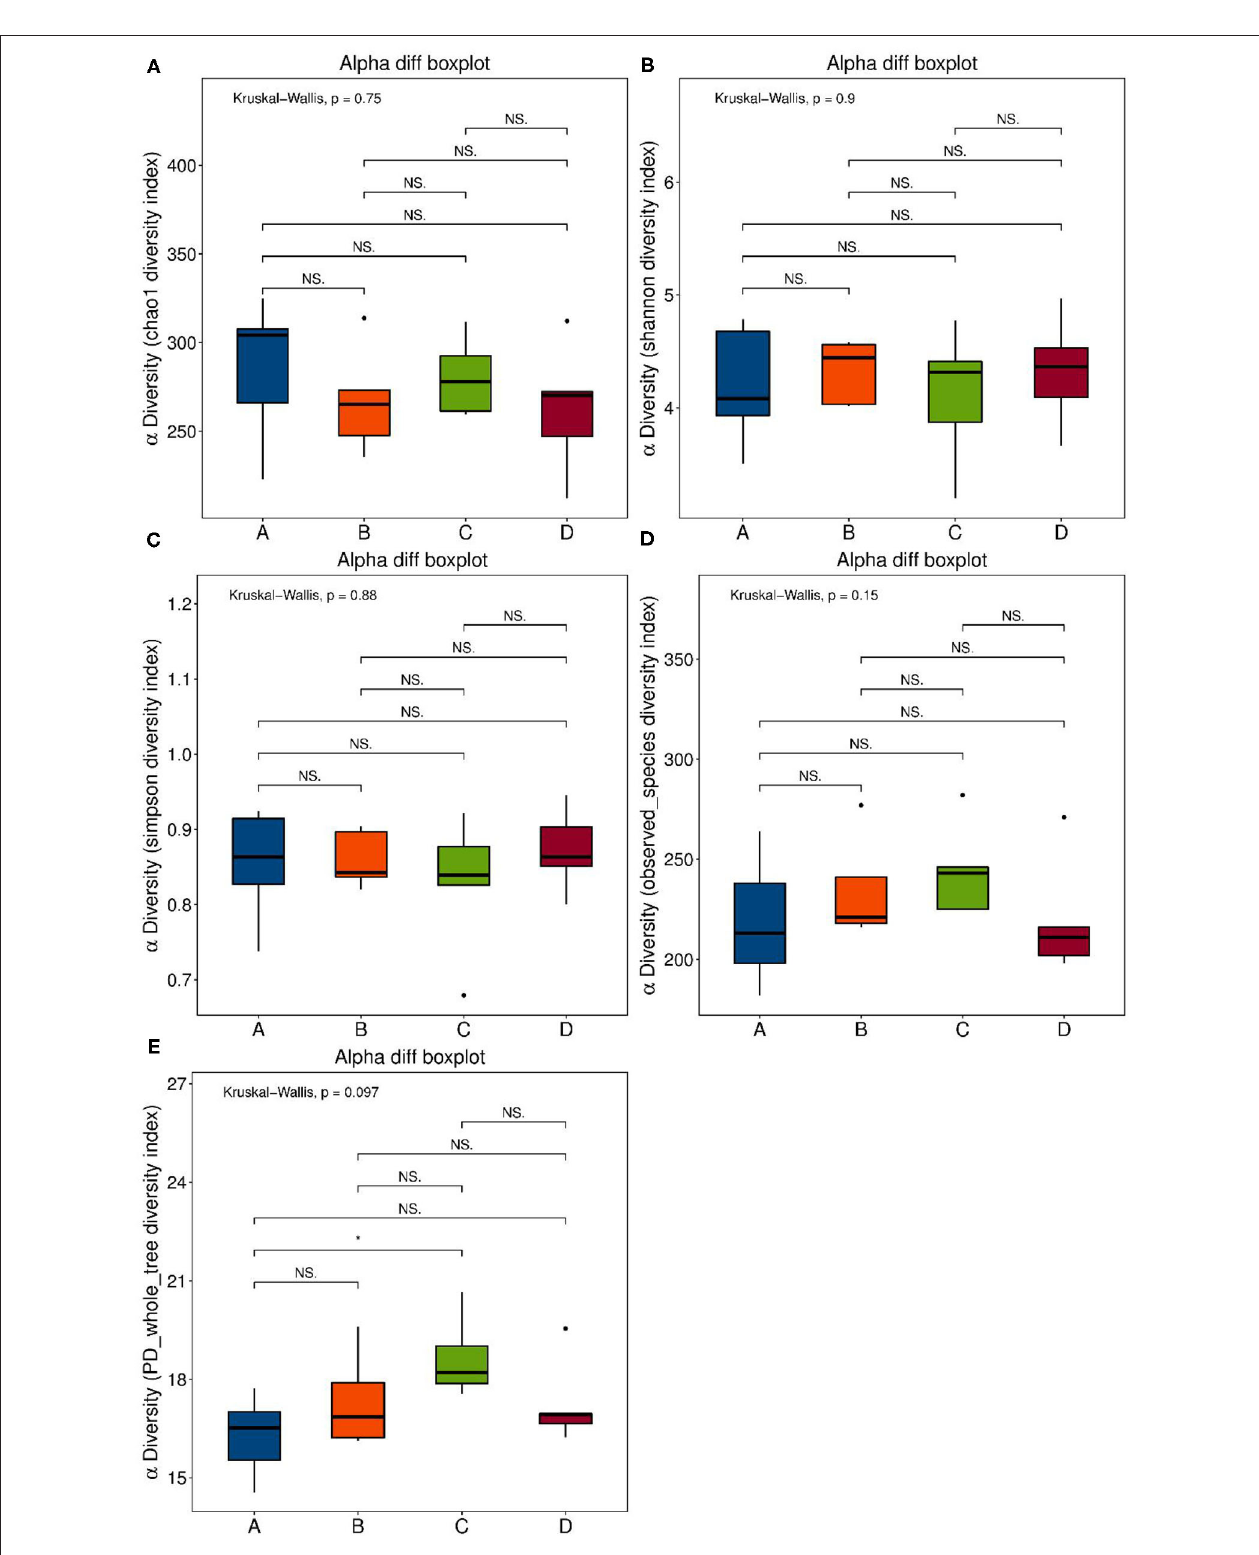
FIGURE 3 | α diversity index. (A) Chao1 index: the differences between the four groups were not statistically significant; (B) Shannon index: the differences between four groups were not statistically significant; (C) Simpson index: the differences between four groups is not statistically significant; (D) Observed-species diversity: the differences between four groups were not statistically significant; (E) PD-whole-tree index: the differences between the four groups were not statistically significant.